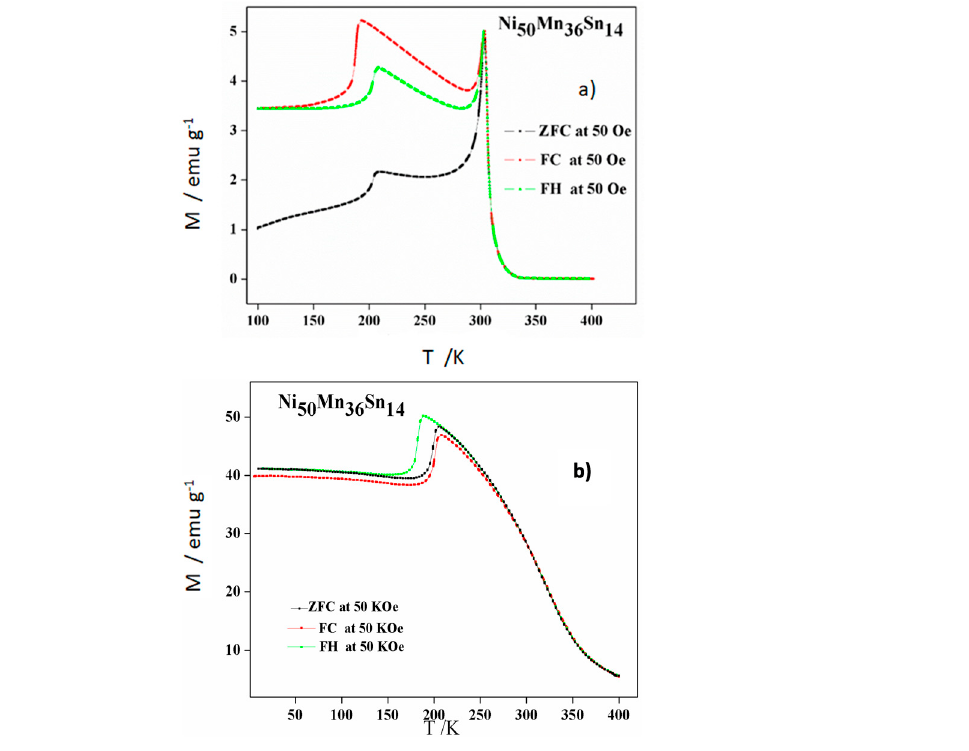
Figure 5. ZFC, FH, and FC thermomagnetic measurements of alloy Ni 50 Mn 36 Sn 14 . ( a ) 50 Oe and ( b ) 50 KOe.